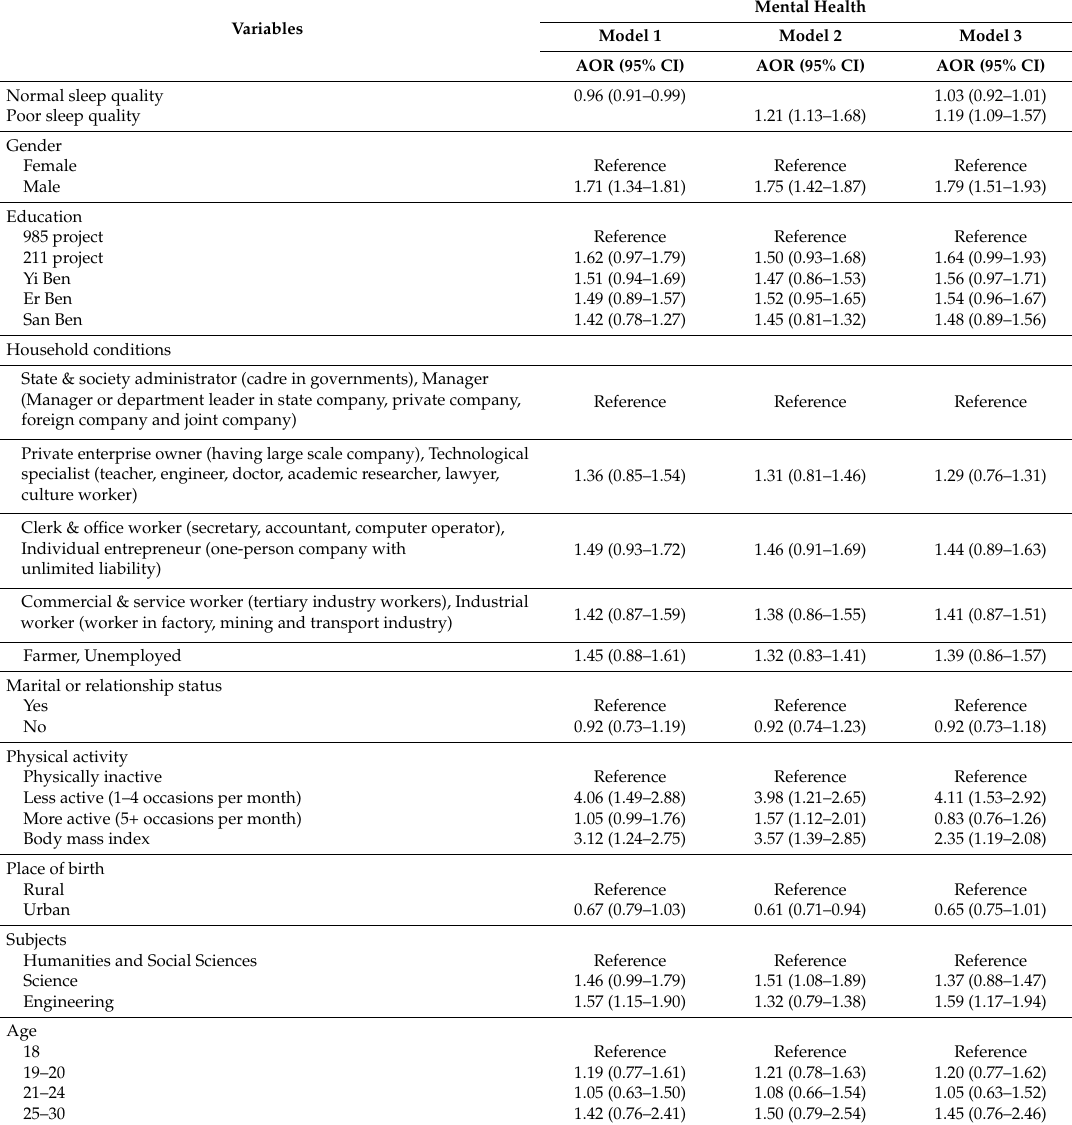
Table 4. Multivariable associations of psychological well-being operationalized in tertiles ( N =